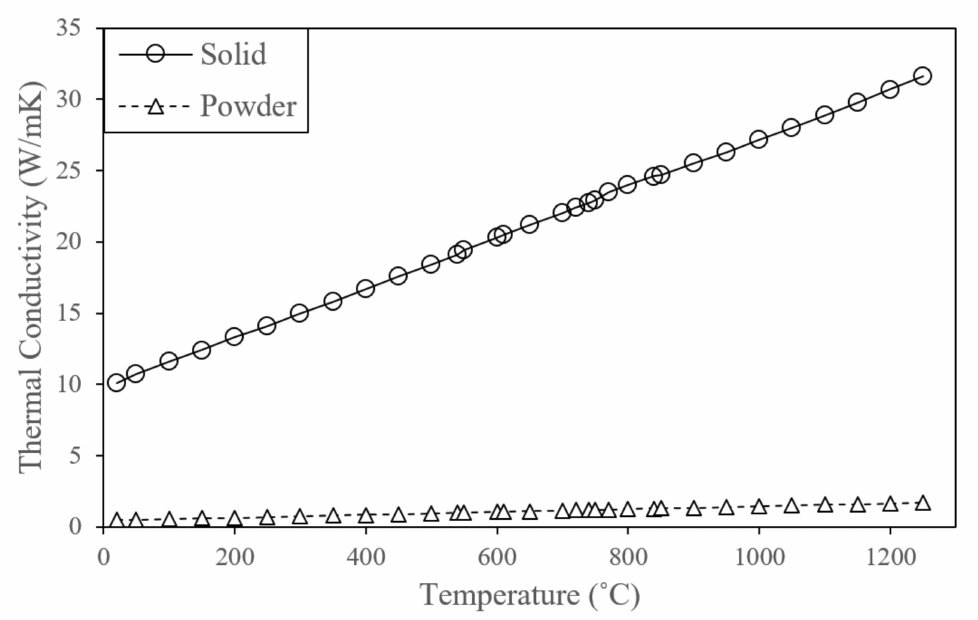
Figure 1. Thermal conductivity of solid vs. powder IN625.